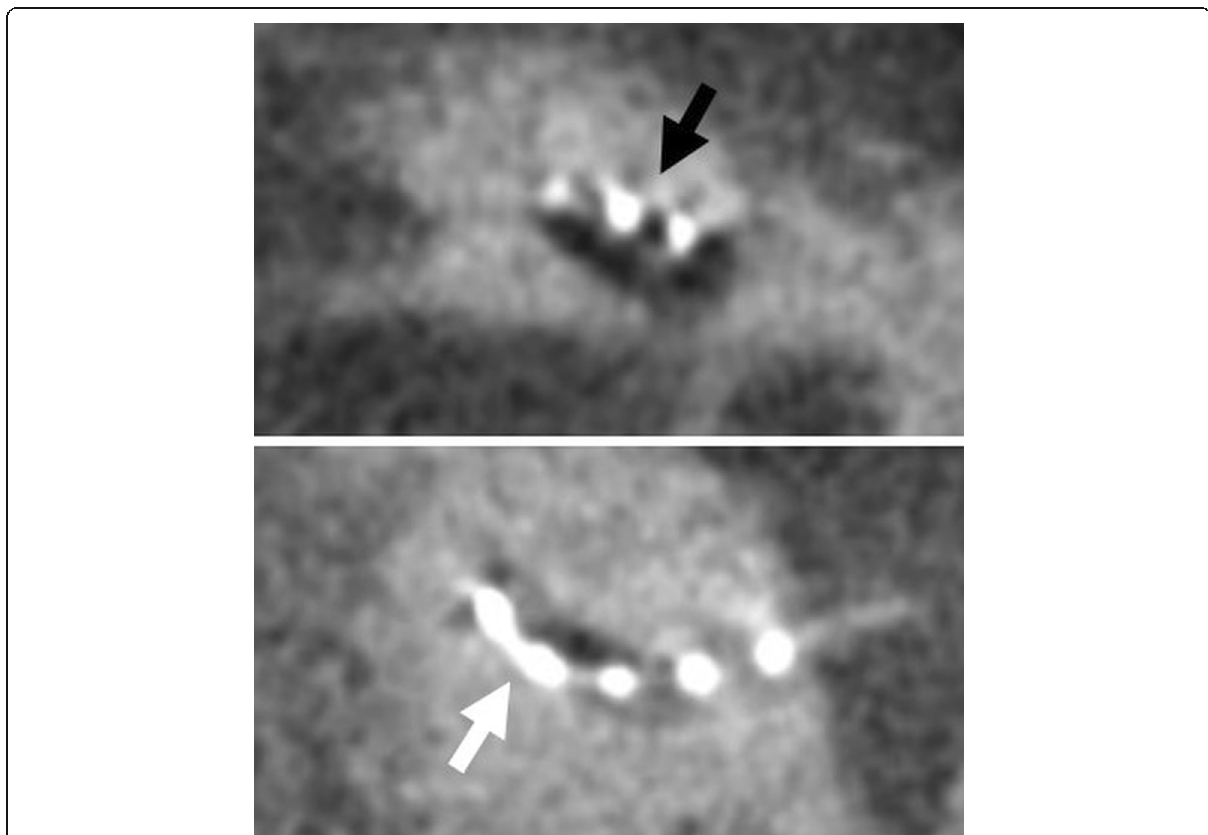
Fig. 25 A 62-year-old male patient, with the scalar translocated electrode. CBCT axial images show translocation of the electrode array from scala tympani (white arrow) into scala vestibuli (black arrow). The electrode was inserted via cochleostomy